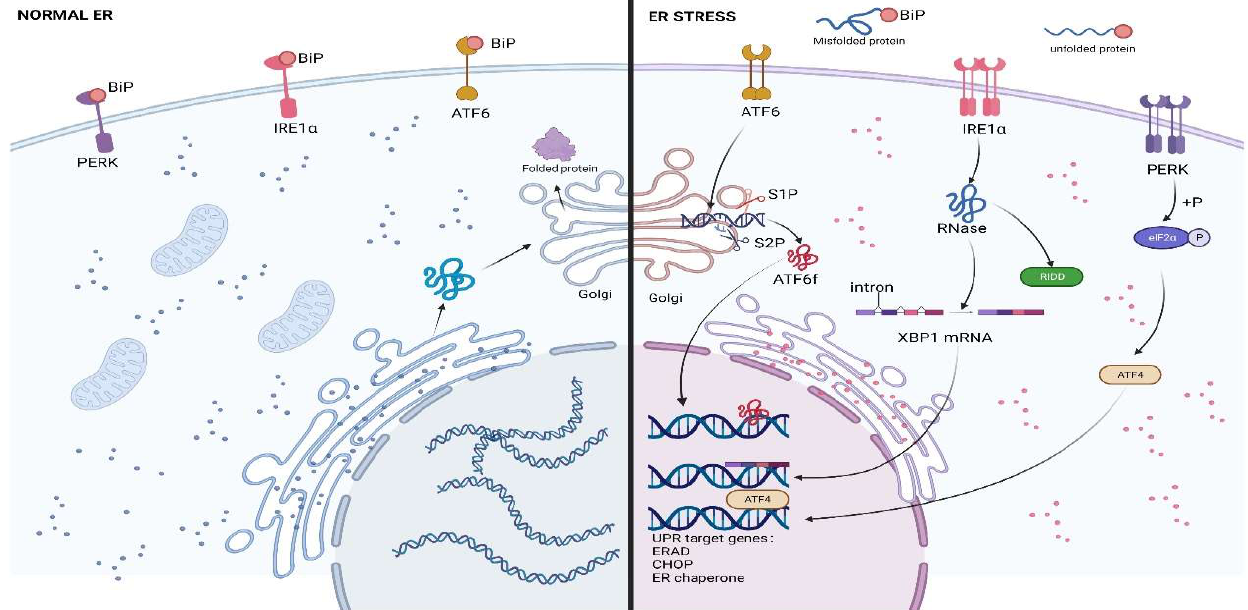
Figure 1. The three branches of the endoplasmic reticulum stress response (ERS) and the unfolded protein response (UPR). When unfolded or misfolded proteins accumulate, the UPR is triggered in the cell to restore endoplasmic reticulum homeostasis. The UPR is transduced by three sensors: IRE1, PERK, and ATF6. Under ERS, Bip is separated from each of the three sensors, which allows them to be activated and subsequently activates downstream transcription factors that promote the expression of UPR target genes (ERAD components, CHOP, and ER chaperones). IRE1 is also involved in the regulated IRE1-dependent decay (RIDD) process to reduce the quantity of proteins entering the ER and alleviate ERS. This figure has been created with https://app.biorender.com (accessed on 20 July 2022).